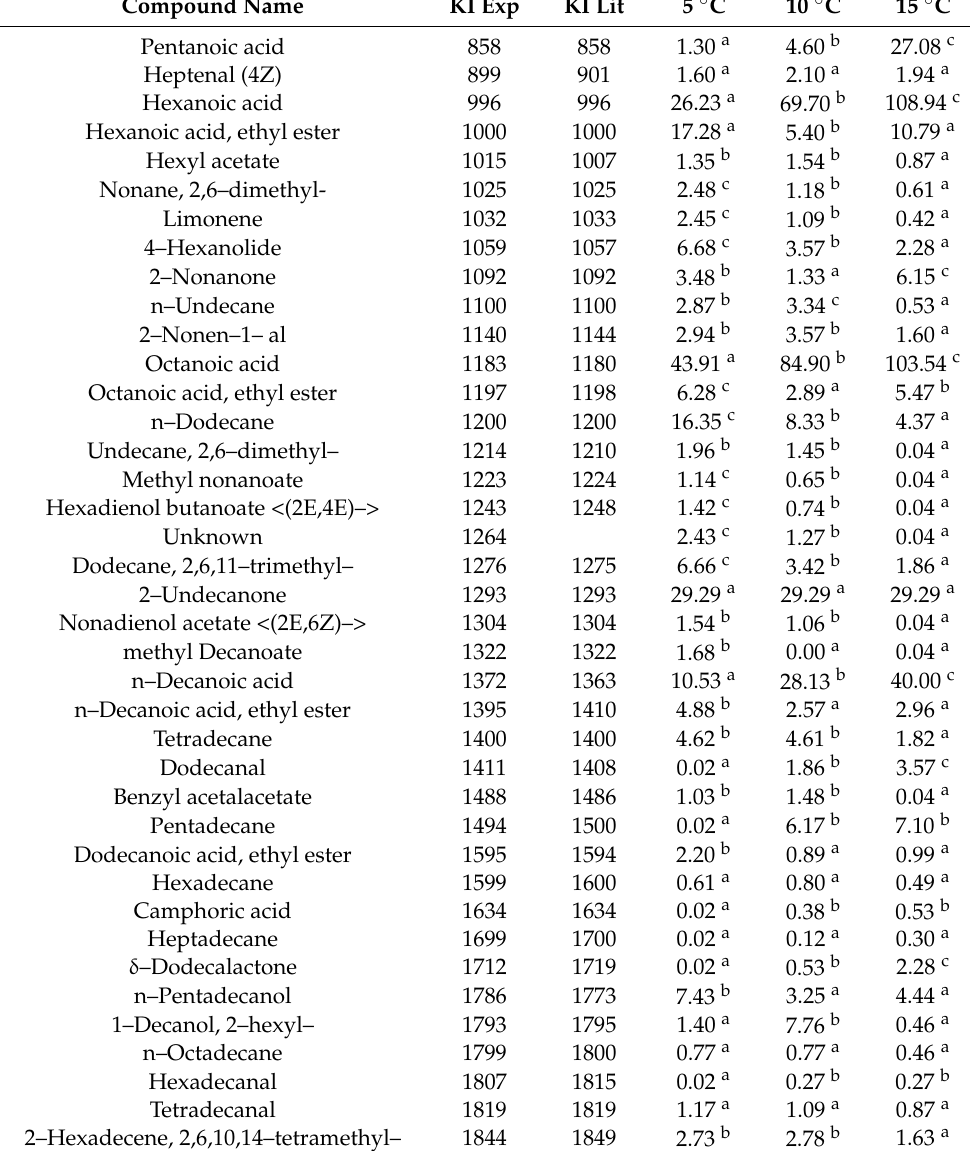
Table 1. Volatile content in analyzed cheese [ µ g/kg]. The content of chemical compounds in the aroma is marked with the same letters (a, b, c) when they do not differ statistically significantly. Statistically homogeneous groups at α = 0.05 marked with the same